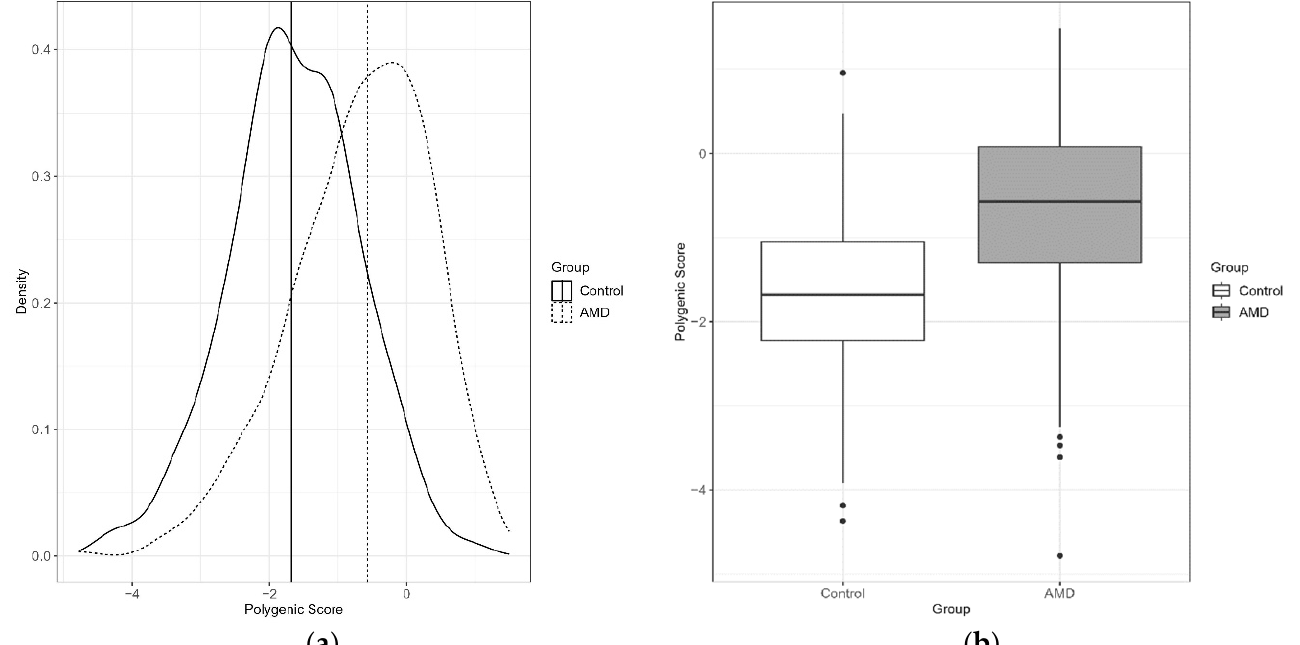
Figure 1. ( a ) Distribution of PRS values per individual as density plot with median values for case/control groups marked as a vertical lines; ( b ) Boxplots showing the distribution of PRS in control and AMD groups.